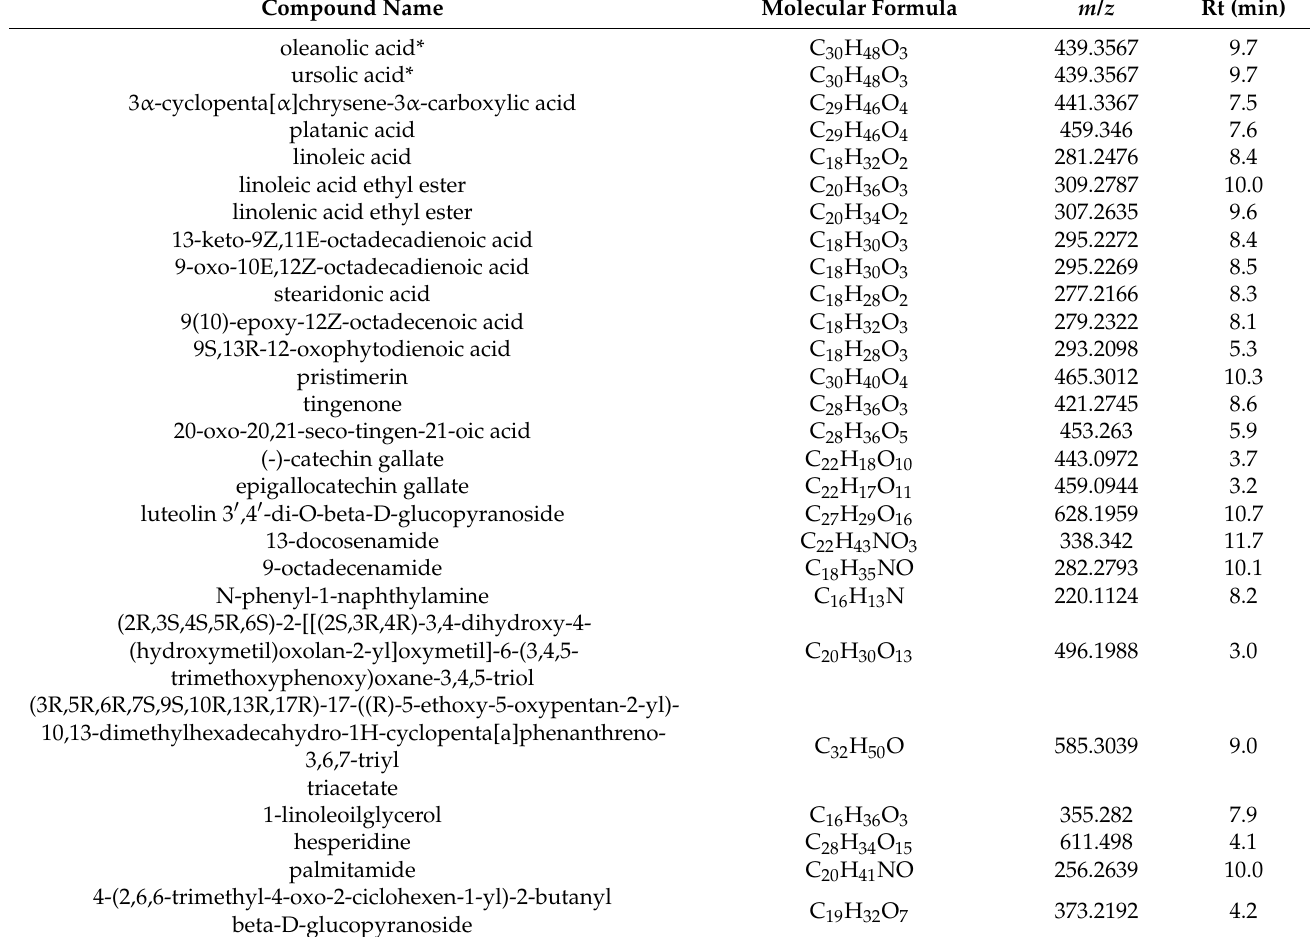
Table 2. Compounds annotated by molecular networking of 17 Cerrado plant crude